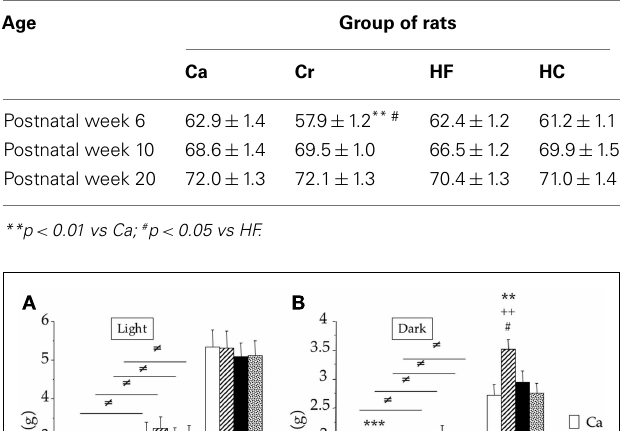
Table 4 | Post-weaning energy intake (mean ± SEM in kcal/day) in offspring from dams fed either a gestational control diet (Ca group) ad libitum , or a restricted control (Cr group), a high-fat (HF group), or a high-carbohydrate (HC group) diet ad libitum for 6h during the light period, in addition to two normal meals given during the dark period.